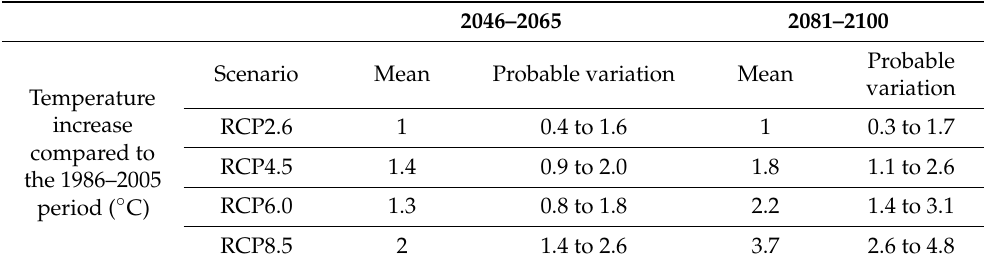
Table 1. Future climate change projections. Source: IPCC,